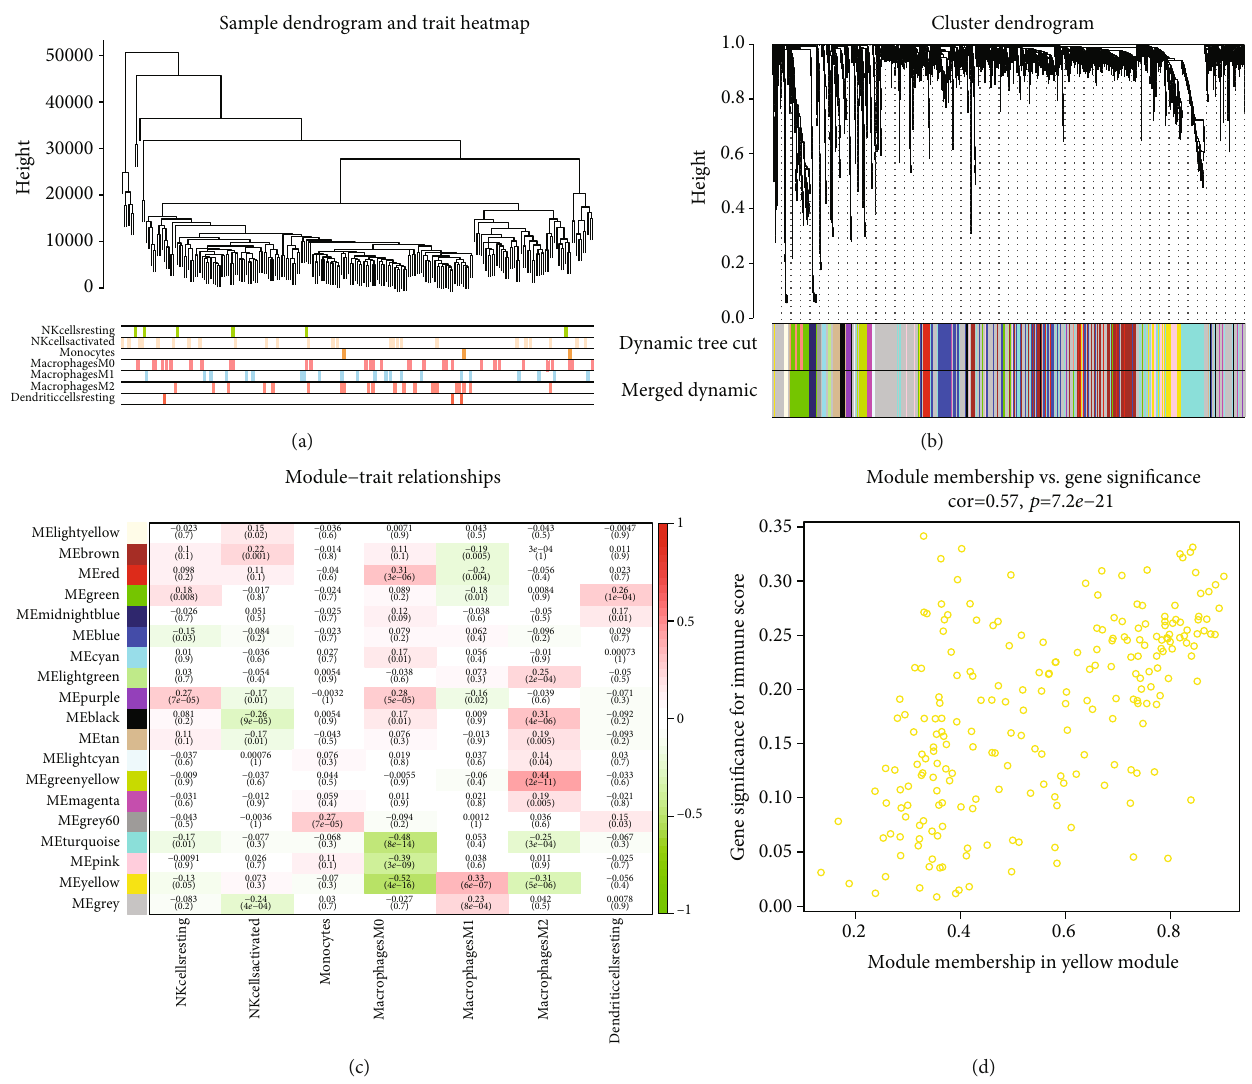
Figure 2: WGCNA analysis of SKCM-FPKM. (a) A hierarchical clustering tree is constructed by using the dynamic hybrid cutting method. (b) Each leaf represented one gene, each branch represented one coexpression module, and 19 coexpression modules were established. (c) The correlation coe ffi cient between di ff erent phenotypes and coexpression modules was shown. The positive correlation between the green-yellow module and the M2 macrophage ratio was strongest ( Cor = 0 : 44 ; p = 2 e – 11 ). The yellow module was correlated with the proportion of M2 macrophages ( Cor = − 0 : 31 ; p = 5 e – 06 ). (d) Heat map of correlation between factors in the green-yellow module ( Cor = 0 : 64 , p = 3 : 4 e – 13